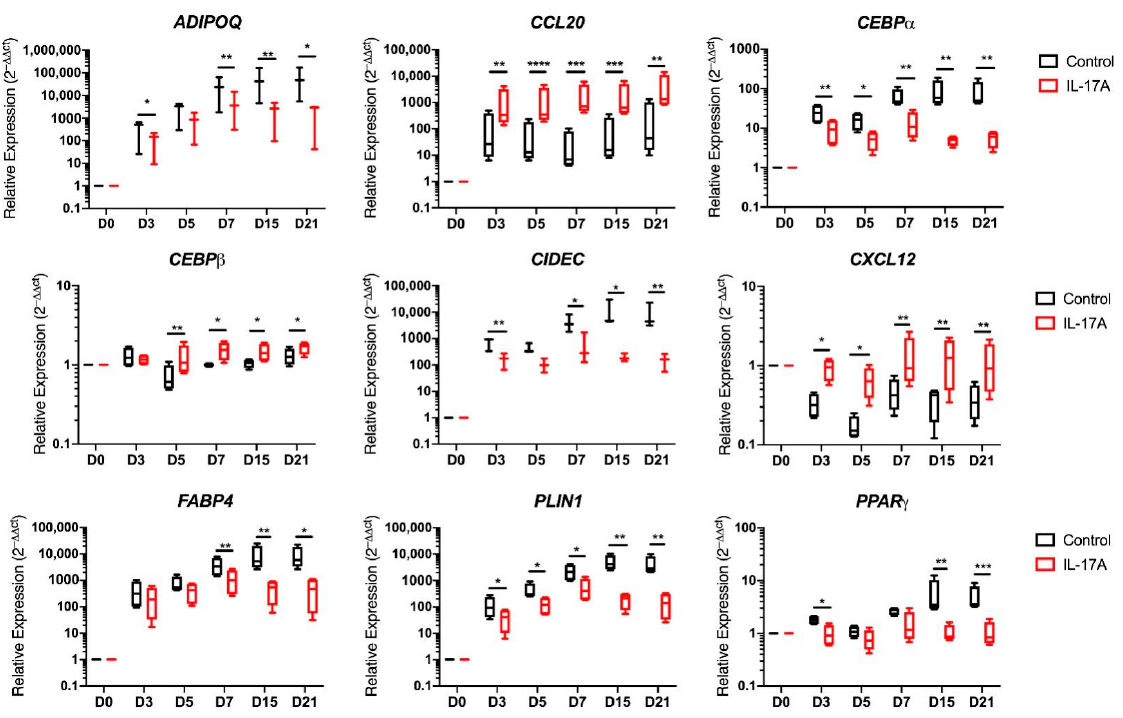
Figure 5. Entheseal soft tissue (EST) mesenchymal stem cells (MSCs) ( n = 4) undergoing 21-day adipogenesis ± IL-17A (50 ng/mL). Transcripts relating to adipogenesis and vesicle fusion (paired t -tests) showing significant downregulation by the stimulation of IL-17A. Transcripts relating to MSC stromal support ( CXCL12 ) and inflammatory cell migration ( CCL20 ) showing significant upregulation by the stimulation of IL-17A compared to a control adipogenic media. * = p < 0.05, ** = p < 0.01, *** = p < 0.001, and **** = p < 0.0001.